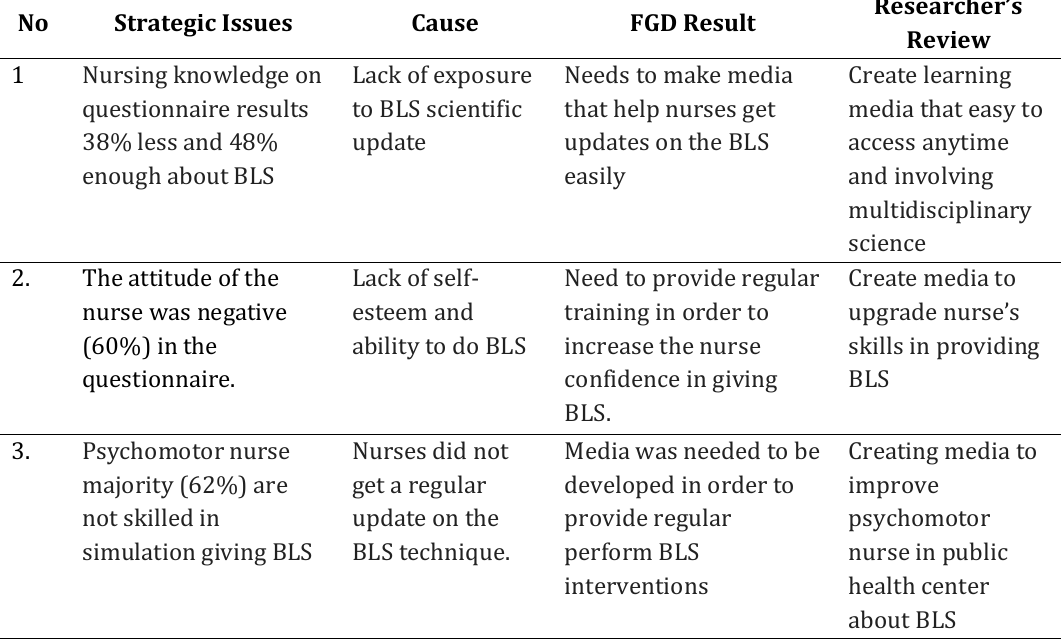
FGD results of knowledge, attitude, and psychomotor evaluation of BLS